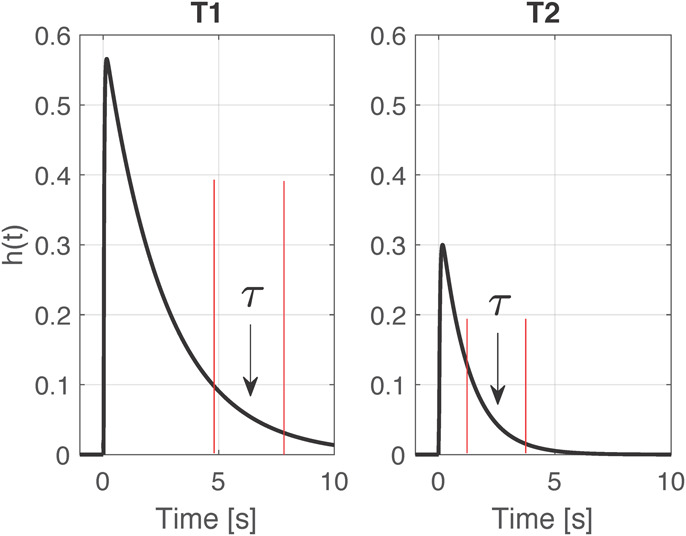
Example of two impulse responses h(t) computed at time point T1 and T2 for one pig. Highlighted in red the time windows selected for the computation of the time constant τ.